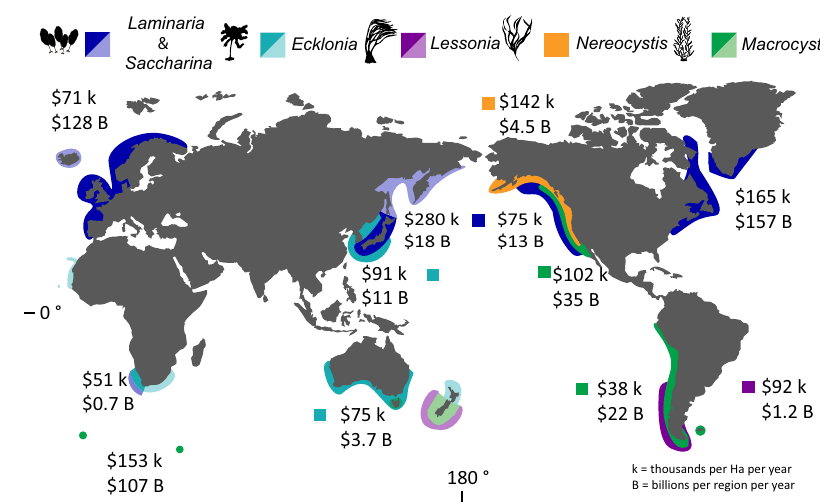
Fig. 4 | Kelp forest distribution and associated economic value by region. Map of kelp distribution, total economic value per m 2 per year (k), regional value (B). Lighter shade colours are for regions where distribution estimates were not avail- ableandthereforethesevalueswerenotincludedintheregionalvaluecalculation.